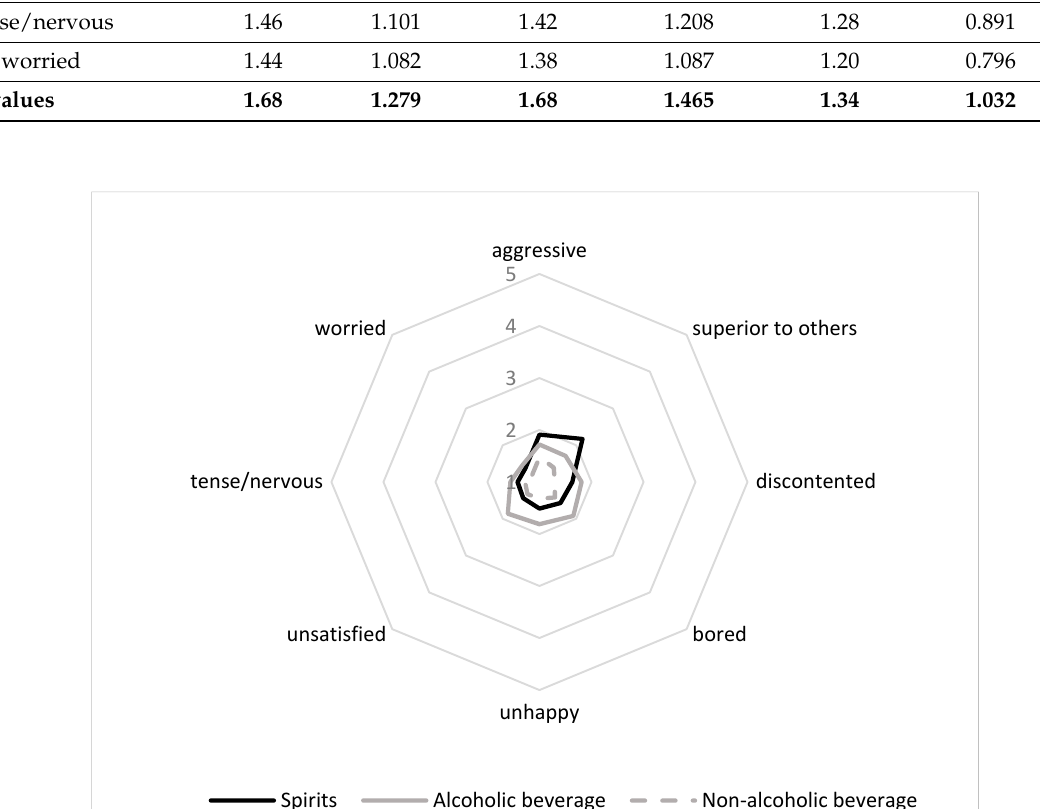
Figure 2. Negative emotional associations with beverage products.